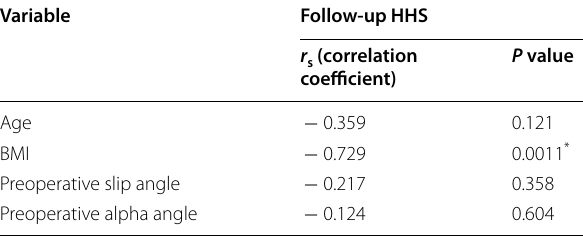
Table 3 Correlation between follow‑up HHS and